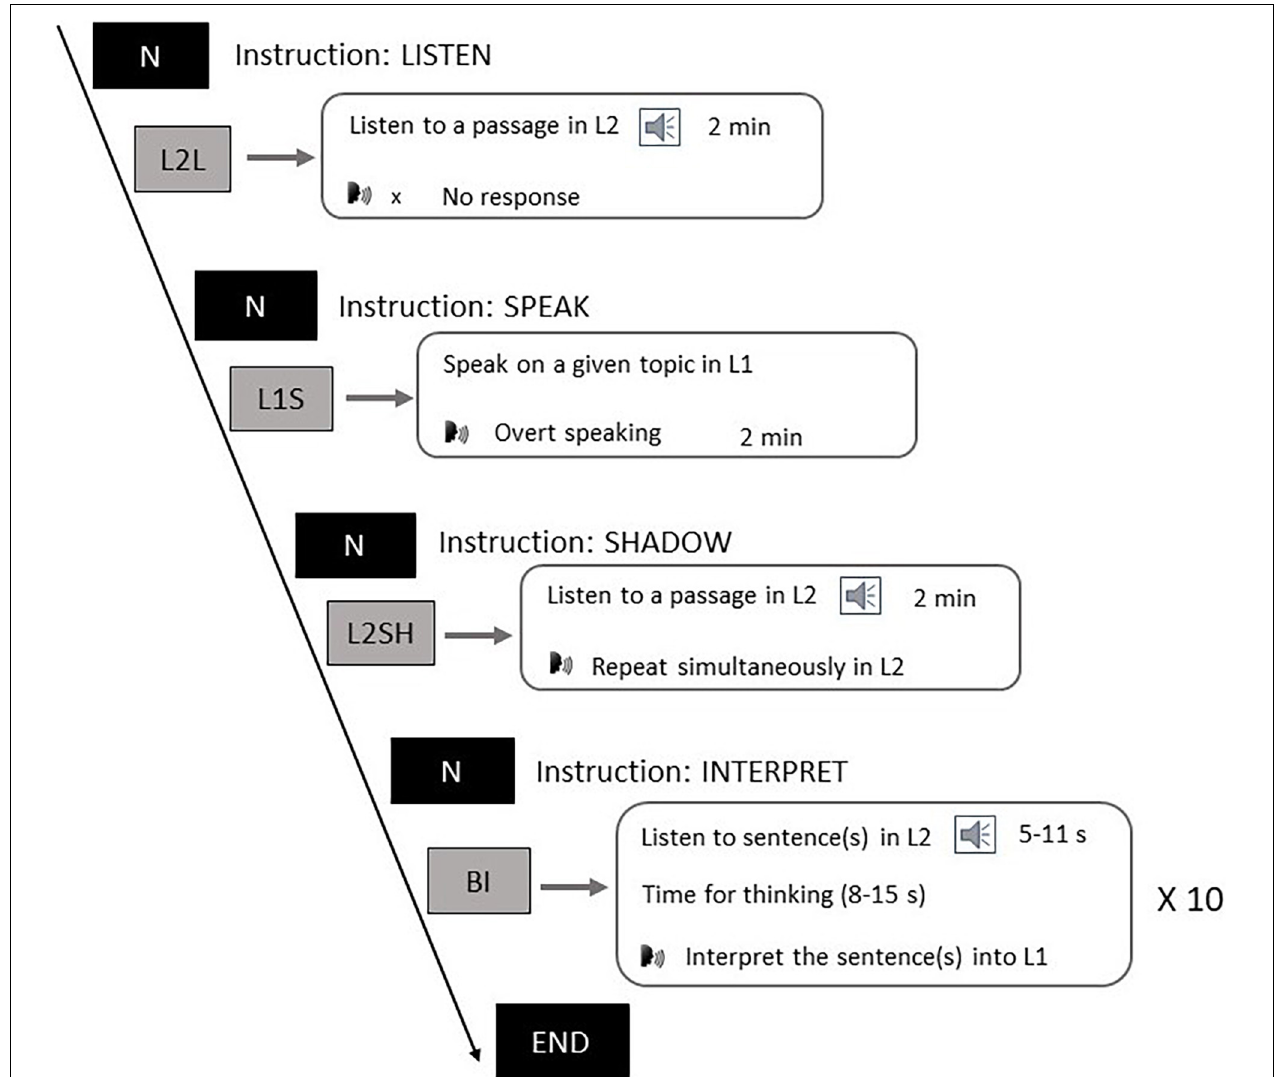
FIGURE 1 | Experiment